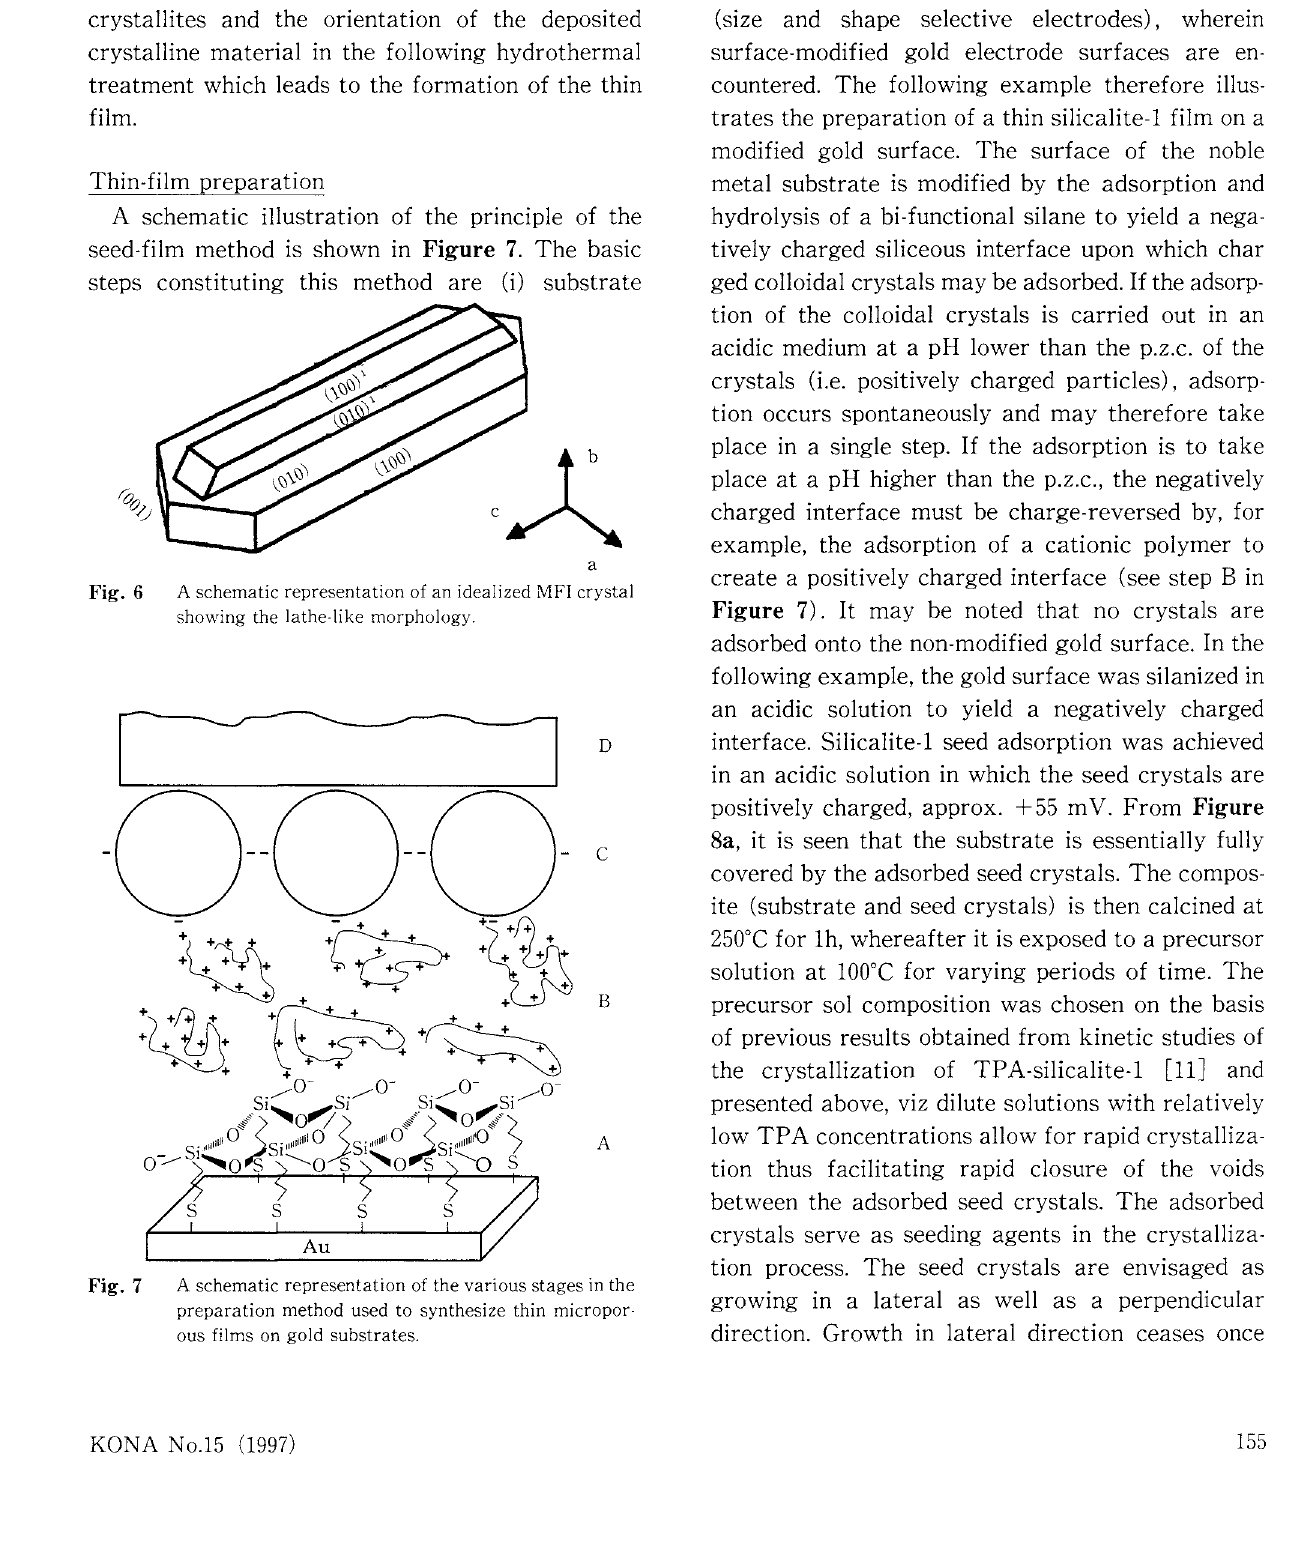
A schematic representation of the various stages in the preparation method used to synthesize thin micropor ous films on gold